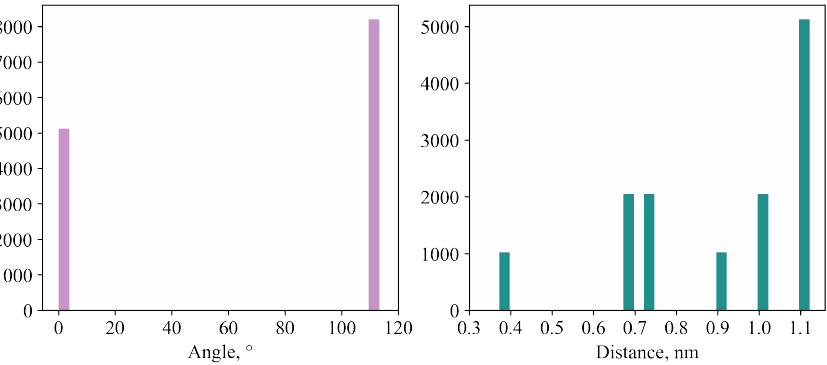
Figure 2. Distribution of angles between normals to the porphine planes in a crystal and distances between the geometric centers of molecules.